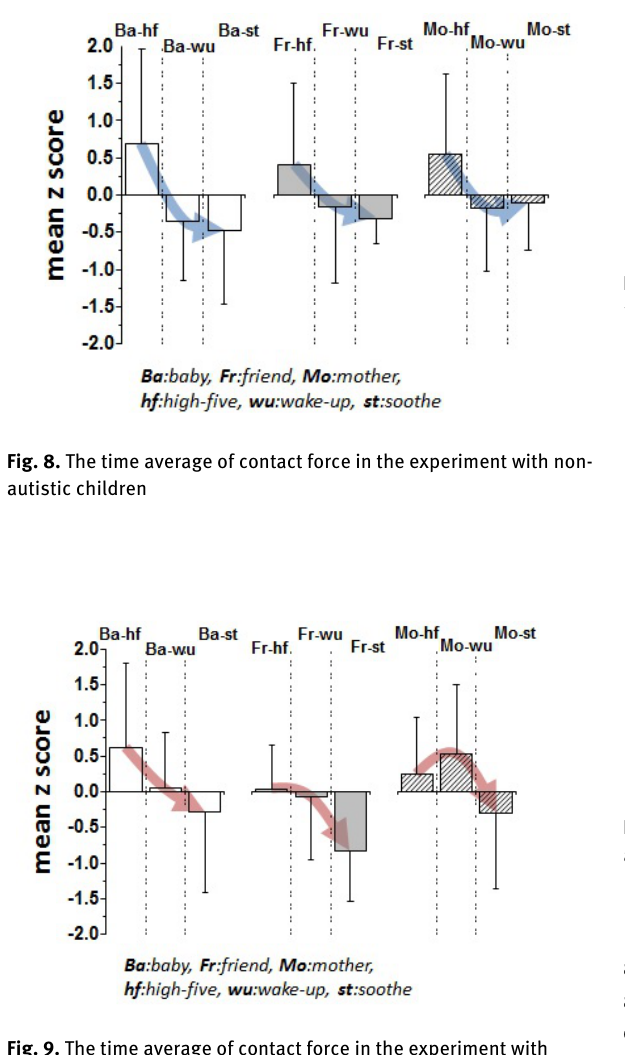
Fig. 9. The time average of contact force in the experiment with autistic children